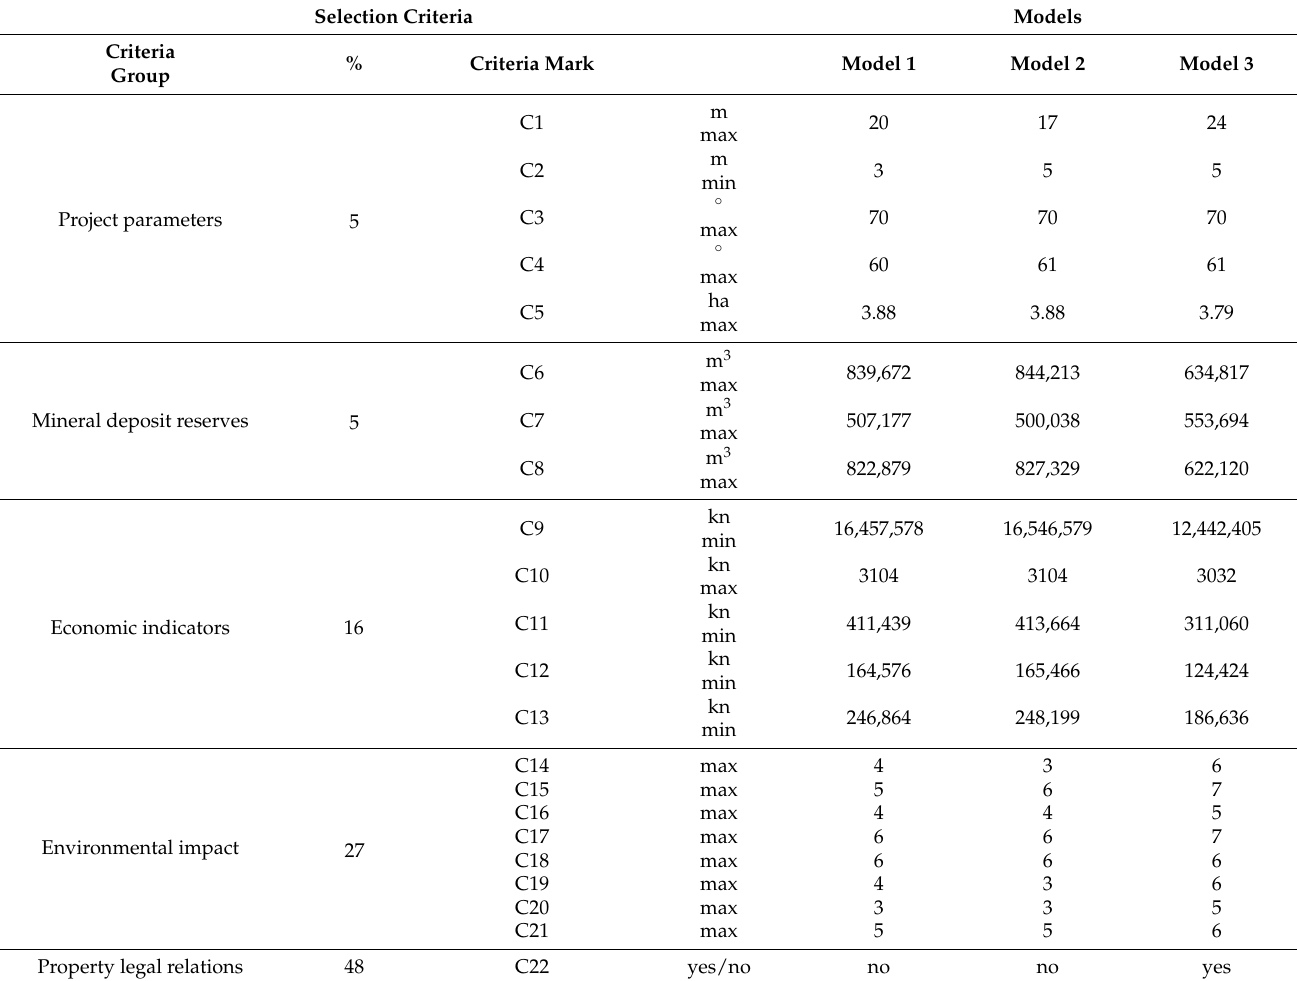
Table 9. Evaluation of criteria for alternative